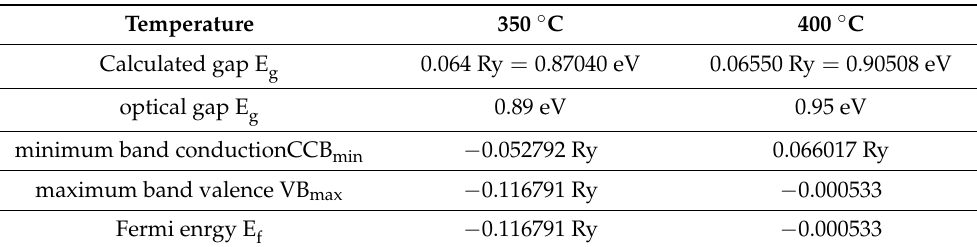
Table 6. Band structure of FeS 2 Parameters.